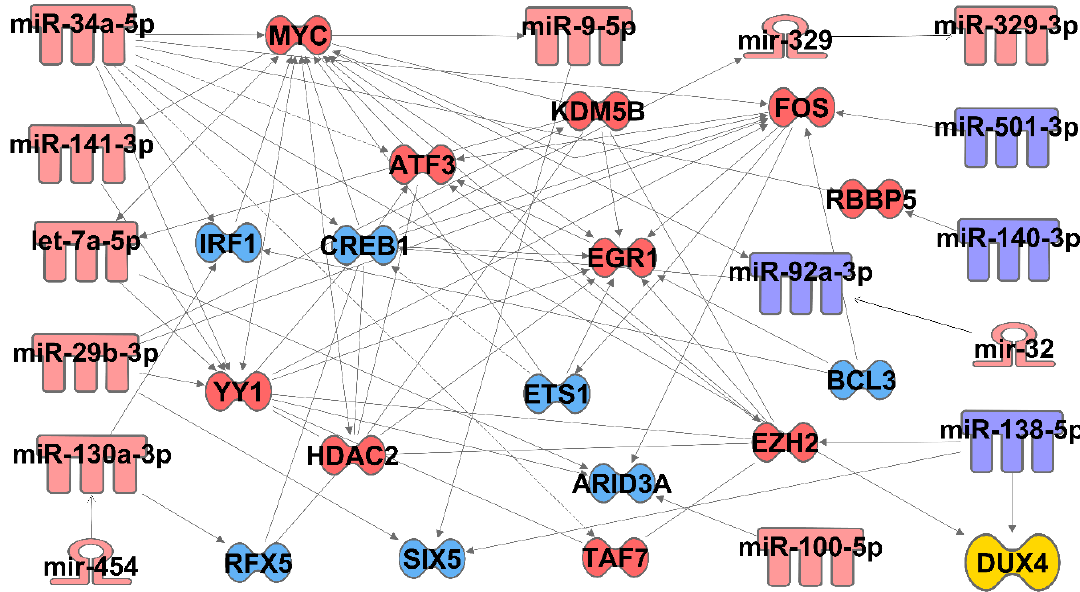
Figure 3. Pathway analysis of miRNAs and transcription factors dysregulated by FSHD mutations. Ingenuity Pathway Analysis software was used to identify established connections between candidate miRNAs from this study with transcription factors known to be dysregulated by FSHD-causing overexpression of DUX4 [9]. Red-shaded miRNAs and transcription factors were observed to increase, while those shaded blue were observed to decrease. Solid arrows denote direct relationships, while dashed arrows denote indirect relationships.